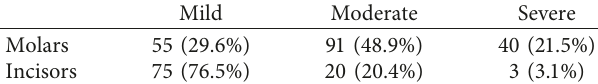
Table 1: Severity score.